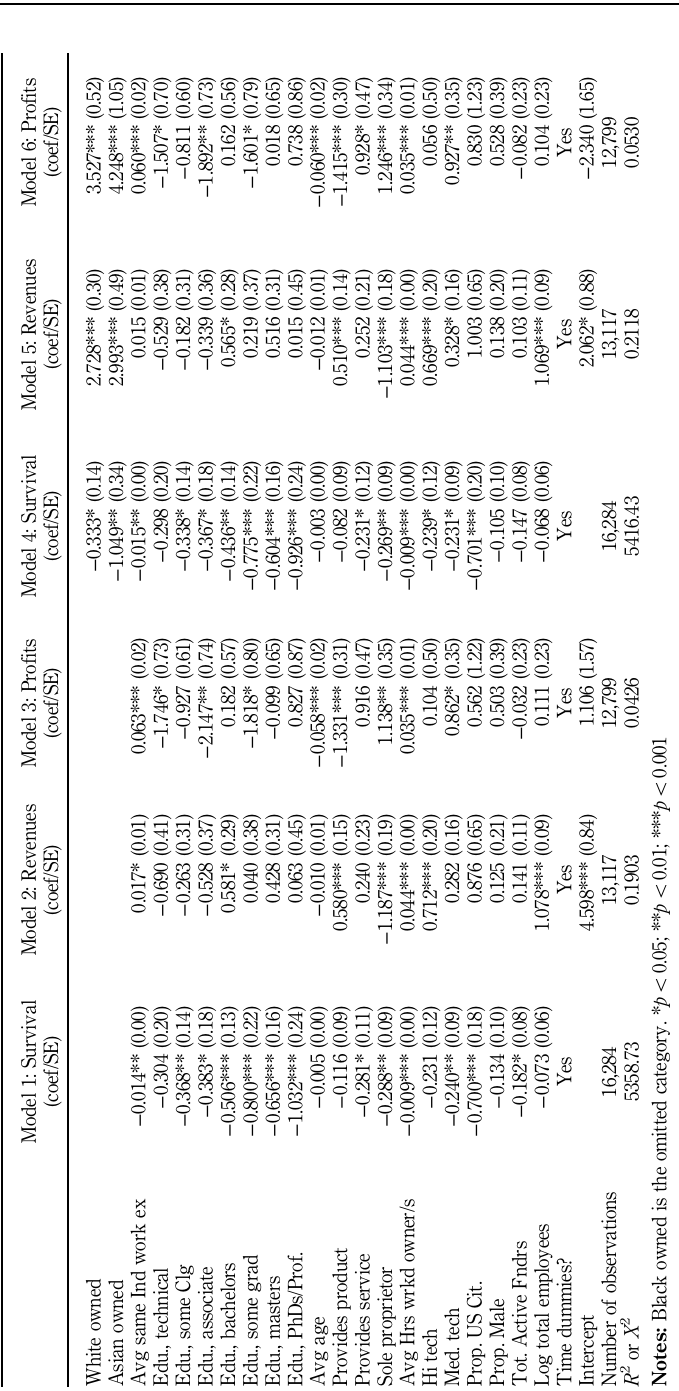
Table VII. Pooled regressions for new